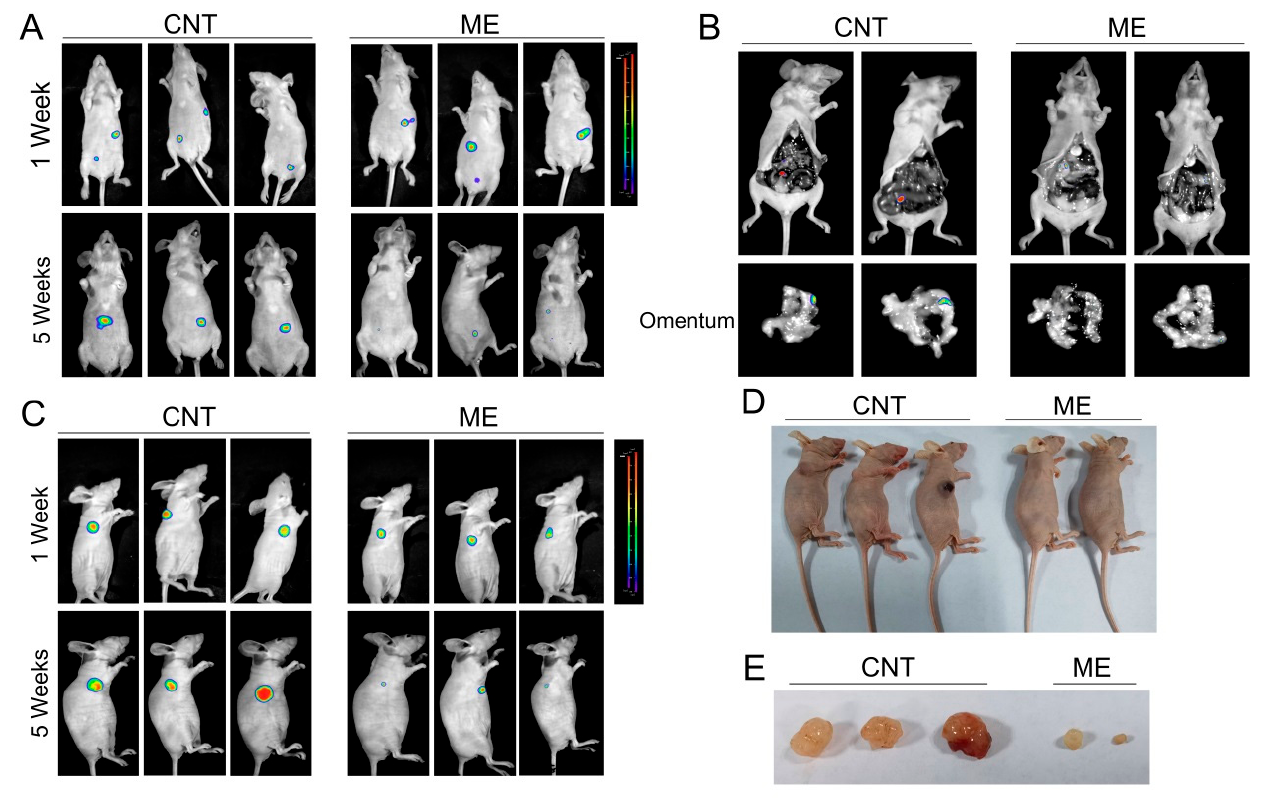
Figure 4. ME treatment inhibits the growth of ovarian tumors in vivo. ( A ) Nude mice were implanted with SKOV3 by two methods, i.e., subcutaneous injection and intraperitoneal injection. The two kinds of tumor-bearing mice were divided into two groups ( n = 3), respectively. Mice receiving ME treatments were administered with ME (1 g/kg, three times a week, oral) daily for four consecutive weeks. After 1 and 5 weeks of cell inoculation, mice were anesthetized. ( A ) Intraperitoneal tumor-bearing mice were injected intraperitoneally with D-luciferin (150 mg/kg body weight); imaging data were acquired 10 min thereafter, and analyzed using Living Image software. ( B ) Intraperitoneal tumor-bearing mice were dissected. Imaging data of the omenta were acquired and analyzed using Living Image software. ( C ) Mice with subcutaneous tumors were injected intraperitoneally with D-luciferin and analyzed using Living Image software. ( D ) Pictures of mice with subcutaneous tumors. ( E ) Photographs of the morphologies of the tumors from each treatment group.